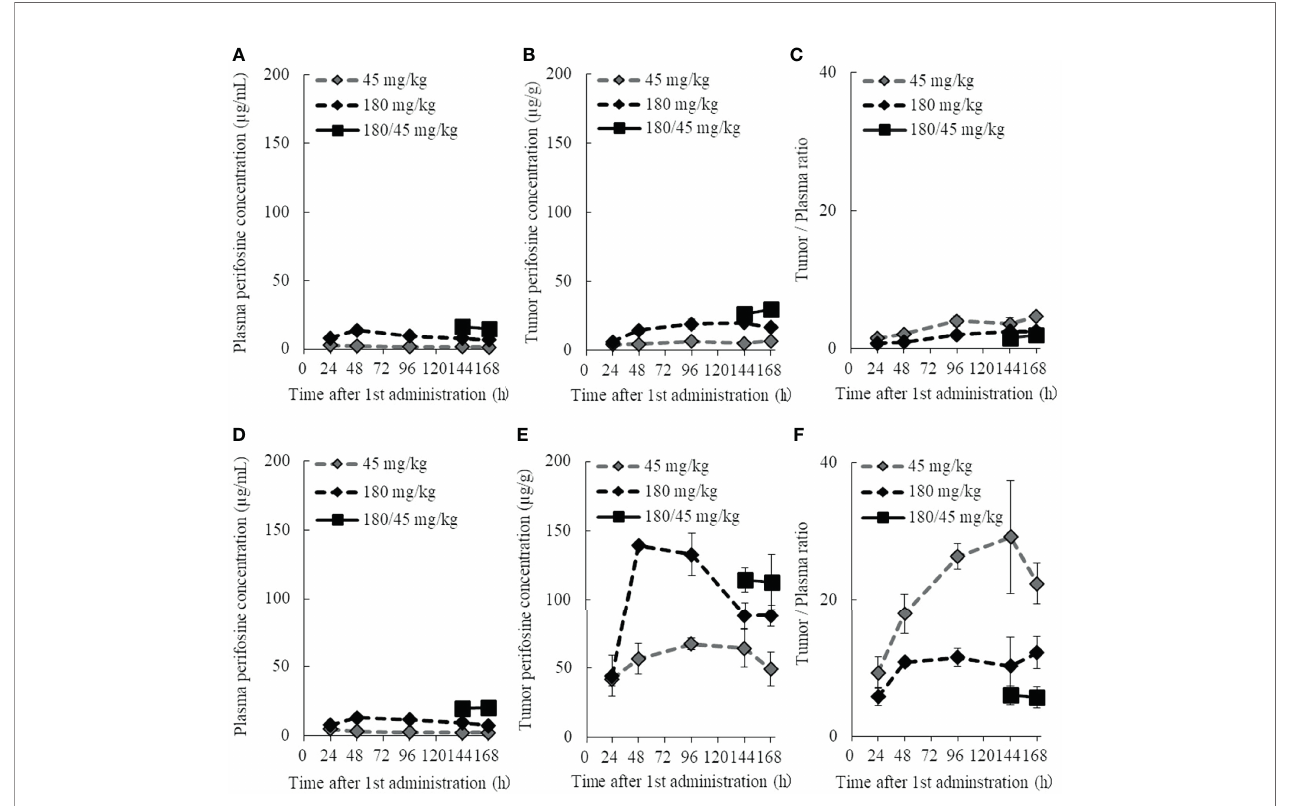
FIGURE 6 | Plasma and tumor pharmacokinetic pro fi les of perifosine after single and repeated doses. Nude mice with DU 145 (A – C) and H1915 (D – F) subcutaneous xenograft tumors were randomized and treated with single doses of 45 and 180 mg/kg perifosine or a 5-day repeated dose of 180/45 mg/kg (180 mg/kg loading dose followed by maintenance doses of 45 mg/kg) perifosine. Plasma (A, D) and tumor (B, E) samples were collected at the indicated points. Chronological changes in tumor-to-plasma ratios of perifosine are shown for DU 145 (C) and H1915 (F) models (n = 3, except at 48-h time point for the 180 mg/kg group in (E, F) , where n = 2 due to tumor sample processing